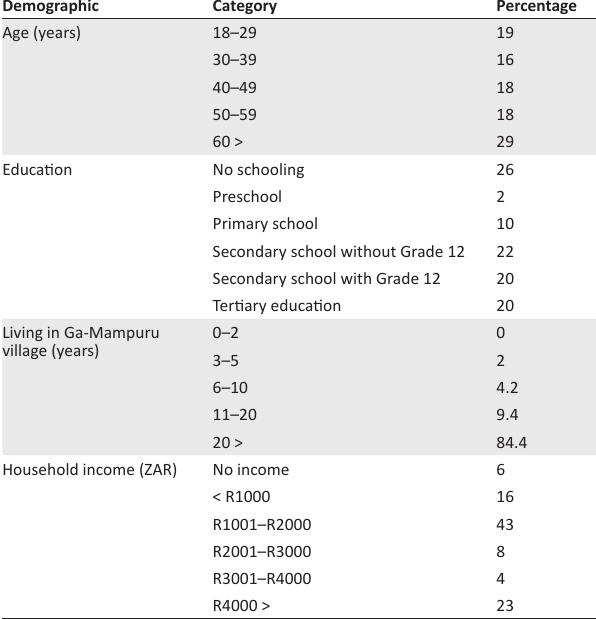
TABLE 1: Respondents’